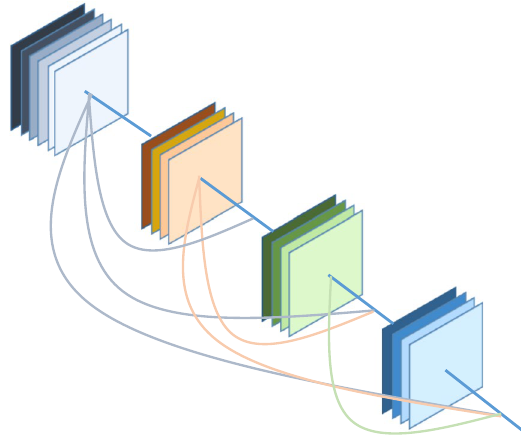
Fig. 3 The dense Block and its